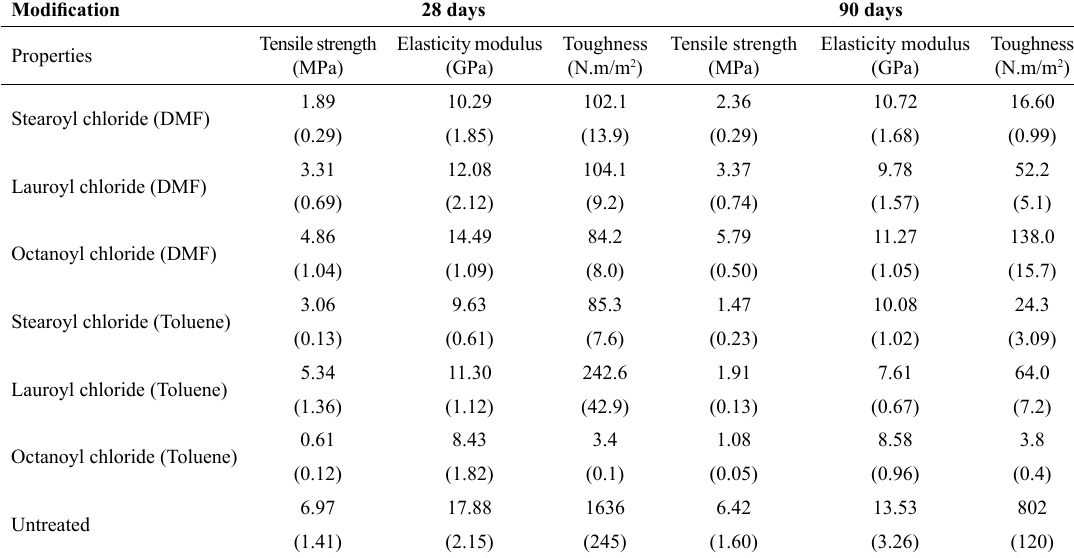
Table 6. Results of bending tests of composites. Modification Properties